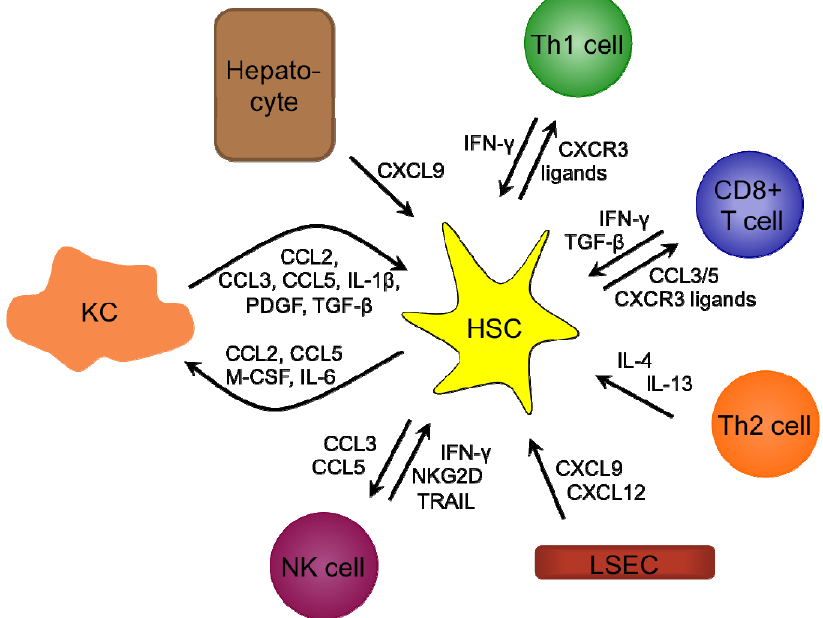
Figure 2. Modulation of hepatic stellate cells (HSCs) during chronic hepatitis C. HSCs are involved in chronic hepatitis C by recruiting immune cells through the secretion of chemokines such as CCL2, CCL5, CXCL9 and CXCL10. KCs contribute to HSC activation by producing CCL2, CCL3, CCL5 and TGF- β , T cells by producing TGF- β and LSECs by secreting CXCL12. CXCL9 produced by hepatocytes and LSECs and IFN- γ produced by NK and T cells are antifibrogenic. In addition, NK cells are antifibrogenic by expressing NKG2D and TRAIL. Activated HSCs proliferate (induced, e.g., by PDGF) and produce collagen (induced e.g., by IL-4, IL-13 and TGF- β ) resulting in liver